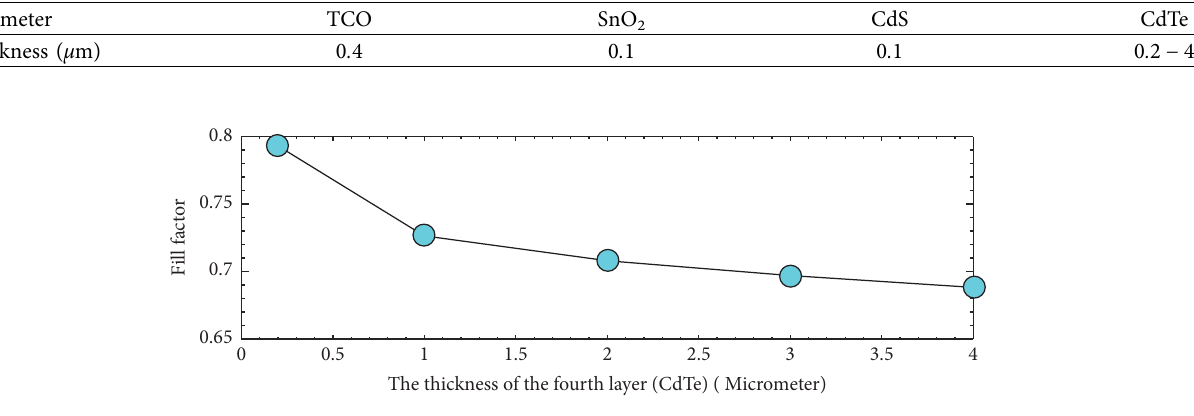
Table 3: Te thickness of the layers in Figures 9–11.